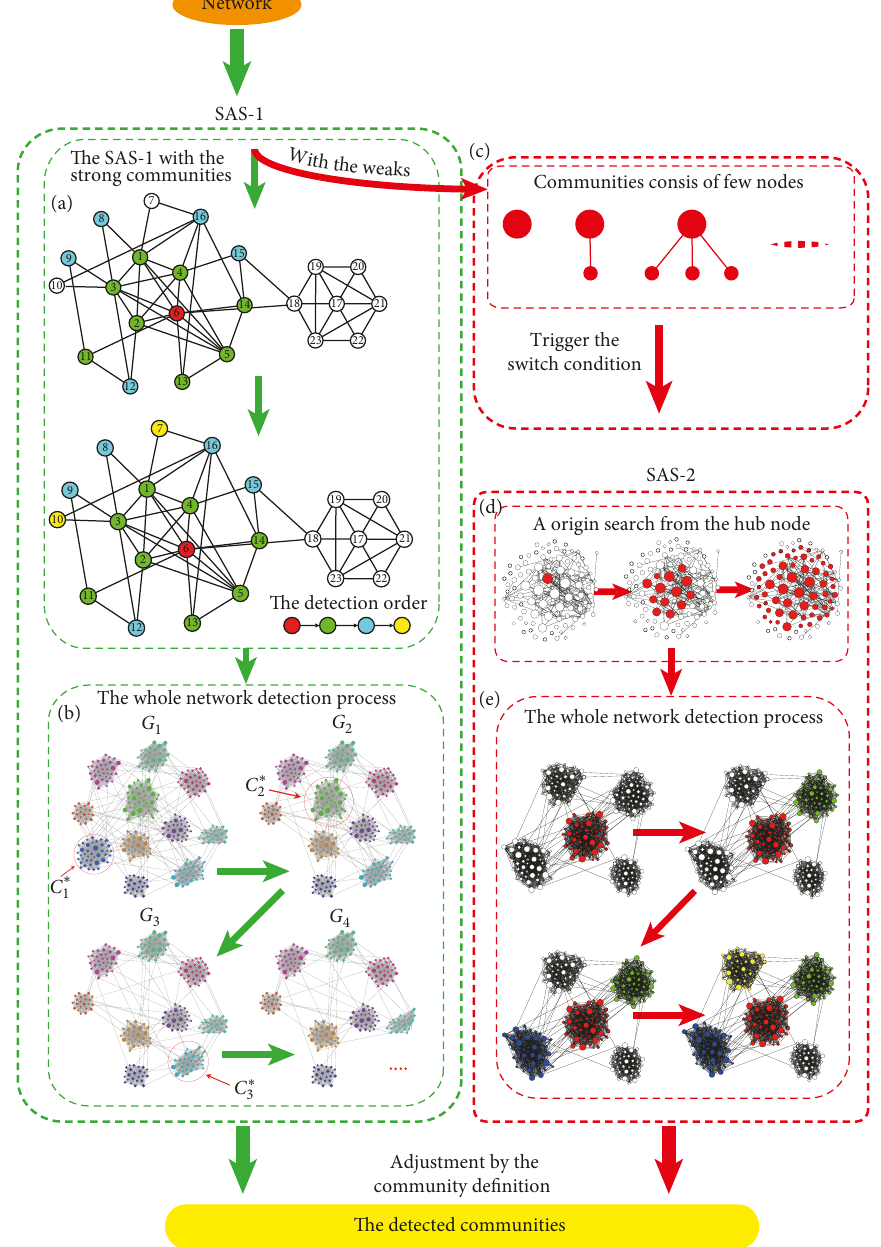
Figure 3: Flowchart of the algorithm with self-adapting switching (i.e., the SAS algorithm) based on affinity. The green area in the left is part of the algorithm SAS-1. (a) The SAS-1 starts from hub nodes and gradually searches their nodes in the same community. (b) After the end of one community detection, the nodes and edges of this community will be deleted in the network, and new network data will be provided for the following detection. The red area in the right is part of the algorithm SAS-2. (c-d) Once the algorithm satisfies the switch condition, the SAS-2 will use the combination of two affinities to detect communities one by one. (e) Different from SAS-1, SAS-2 does not delete communities having been